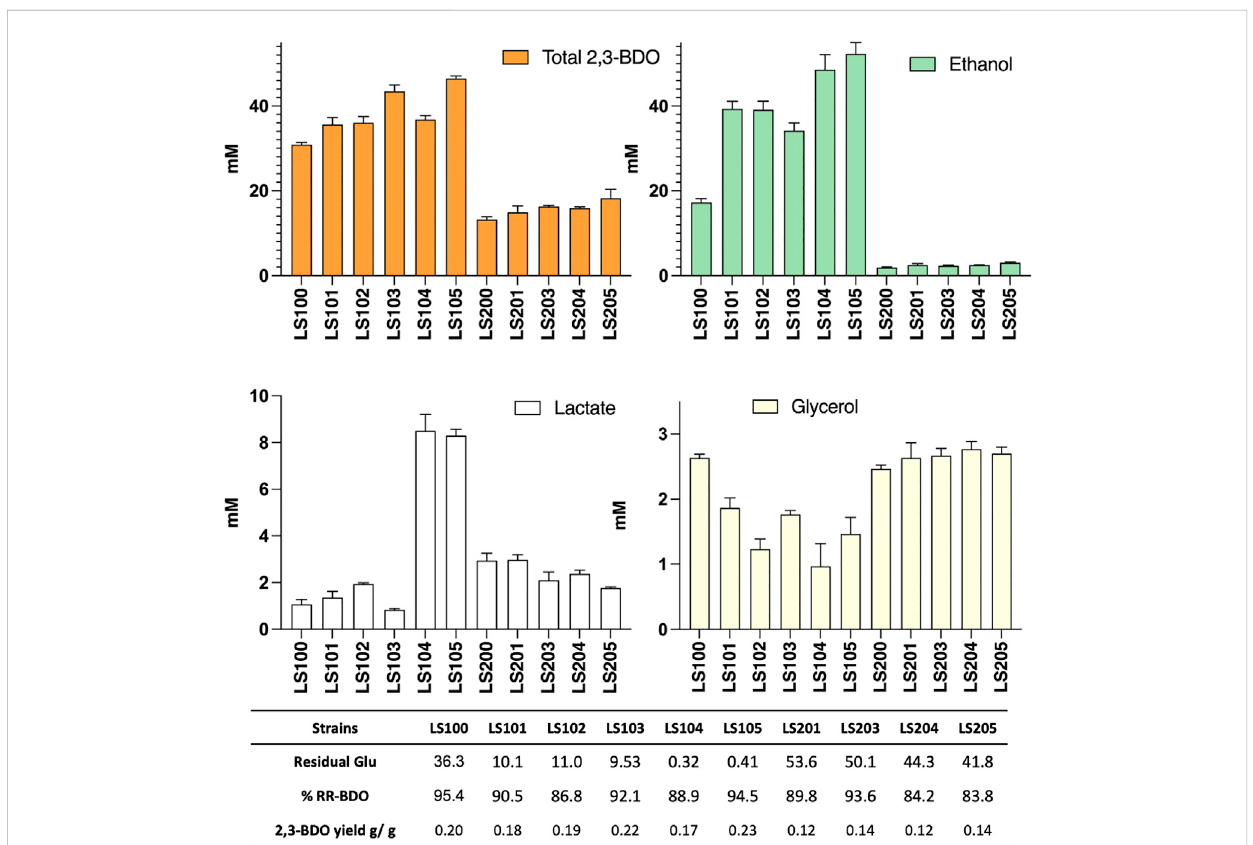
The effect on acetoin and 2,3-BDO yields of targeting various competing pathways in strains with (LS100 — LS105) and without (LS200 — LS205) a functional adhE gene. Allstrains carryplasmid pMTL-DB3 andweregrown at50 ° C for 48 hin10 mLofM-ASYE medium containing 2%(w/v)glucoseand yeast extract in a 50 mL falcon tube with shaking (250 rpm). 2,3-BDO level represents the sum of meso-2,3-butanediol and (R,R)-2,3-butanediol. The presence of an adhE deletion almost eliminated ethanol production but inhibited growth and 2,3-BDO production. Acetoin is not detected under thiscondition.Concentrationsarecalculatedastheaverageofthreebiologicalreplicates.Errorbarsrepresentstandarddeviation.BDO=2,3-butanediol, RR-BDO = RR-2,3-butanediol. Strains with genes deleted are indicated as follows: LS100 ( Δ ldh Δ p fl ), LS101 ( Δ ldh Δ p fl Δ g3pdh1 ), LS102 ( Δ ldh Δ p fl Δ gdh1 ), LS103 ( Δ ldh Δ p fl Δ ldh2 ), LS104 ( Δ ldh Δ p fl Δ g3pdh1 Δ gdh1 ), LS105 ( Δ ldh Δ p fl Δ g3pdh1 Δ gdh1 Δ ldh2 ), LS200 (LS100 Δ adhE ), LS201 (LS101 Δ adhE );